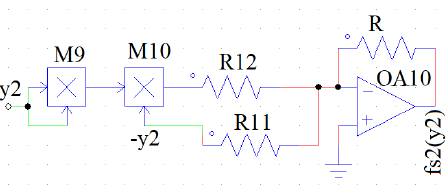
Figure 14. The equivalent circuit diagram of the force due to the magnetic spring f S2 ( y 2 ) . The resistance values are: R 11 = 14.91 k Ω , R 12 = 2.1 k Ω , R = 100 k Ω . OA 10 is the Op-Amp, M 9 and M 1 0 are the two multipliers. (Color Online).